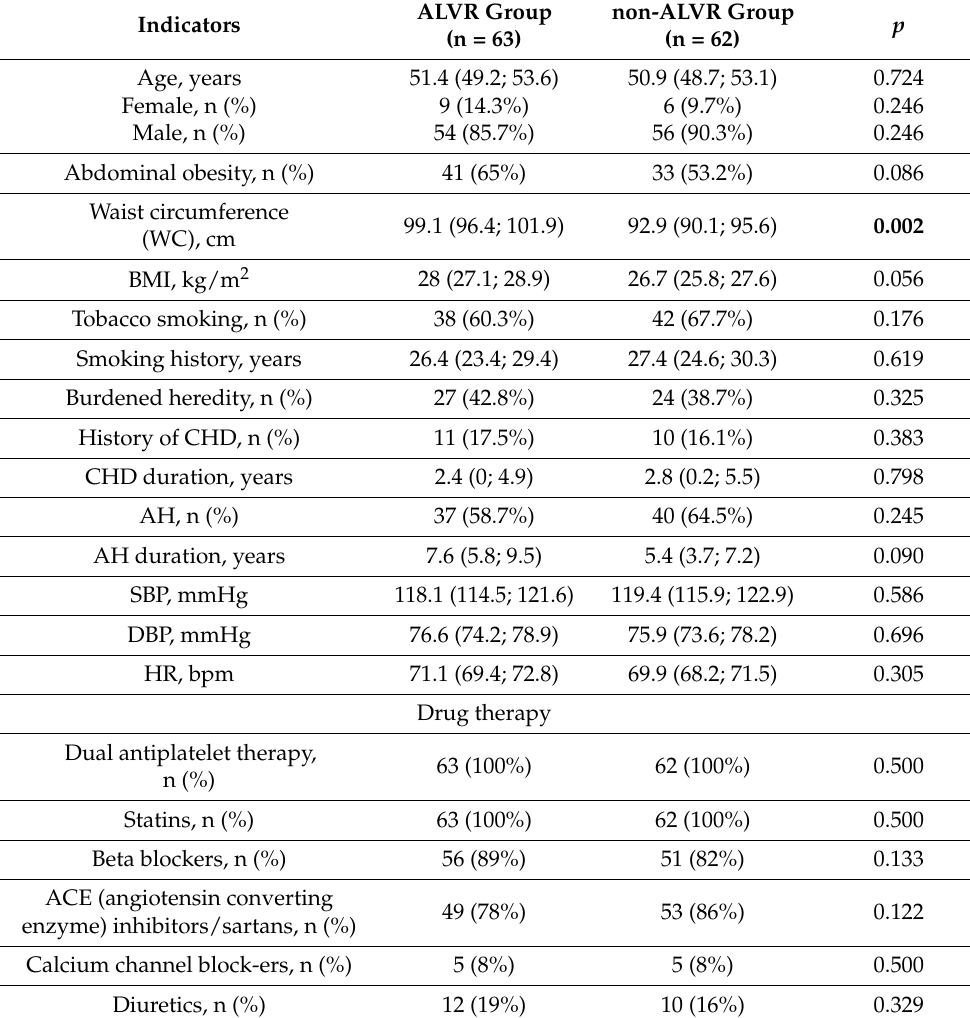
Table 1. A comparative analysis of ALVR and non-ALVR groups (n =